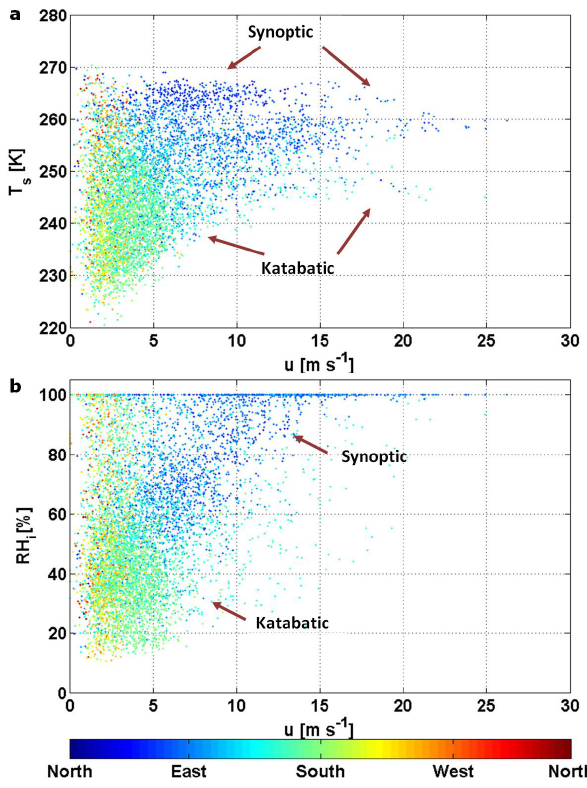
Fig. 10. Scatter plot of (a) surface temperature T s and (b) relative humidity with respect to ice RH i versus wind speed u at AWS 16. The colour of the scatter points represents the wind